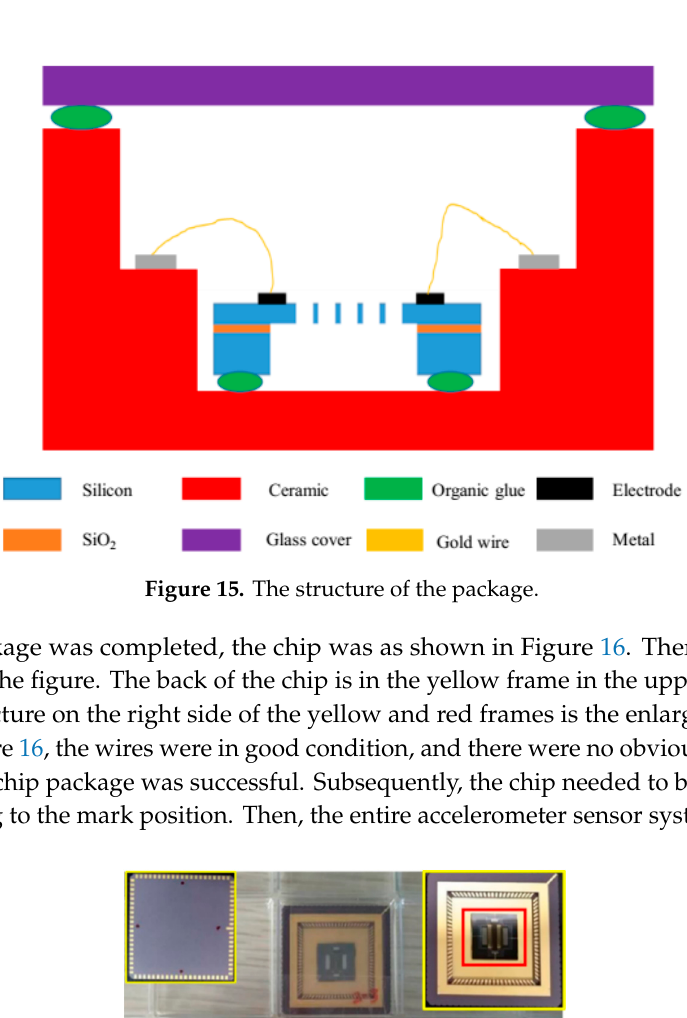
Figure 17. Packaged chip and circuit.